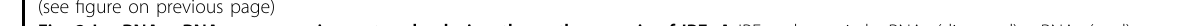
Fig. 2 LncRNA-mRNA co-expression networks during the pathogenesis of IPF. A IPF pathogenic lncRNAs (diamond)-mRNAs (oval) co- expression network in IPF. The nodes marked with red color represent the up-regulated IPF pathogenic genes. The nodes marked with blue color represent the down-regulated IPF pathogenic genes. The solid lines (dotted lines) represent the positive (negative) correlation between mRNAs and lncRNAs (|r| >0.8, P < 0.01, P earson Correlation Test). B Distribution of the degree of genes in the IPF pathogenic network. C Circos plots display chromosomal interactions between co-expressed lncRNAs and mRNAs. The location of lncRNA CTD - 2528L19 .6 was marked with red arrows. D , E KEGG pathways enrichment with IPF pathogenic up-regulated mRNAs ( D ) or down-regulated mRNAs ( E ). FDR < 0.05, Hypergeometric test. Size of the bubble indicates the number of genes in the corresponding annotation. Color shade corresponds to the -log10( p ) value. The closer the color is to red, the more signi fi cant the enrichment is.